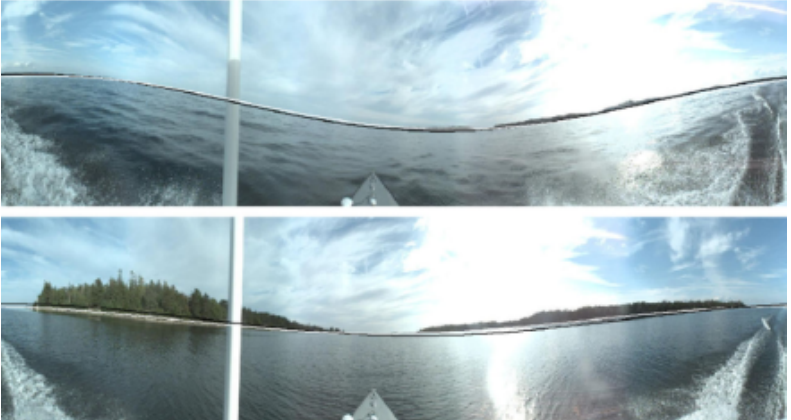
Figure 26. Panoramic view from an unmanned aerial vehicle [3]. Due to the influence of sea waves, the images have a sinusoidal